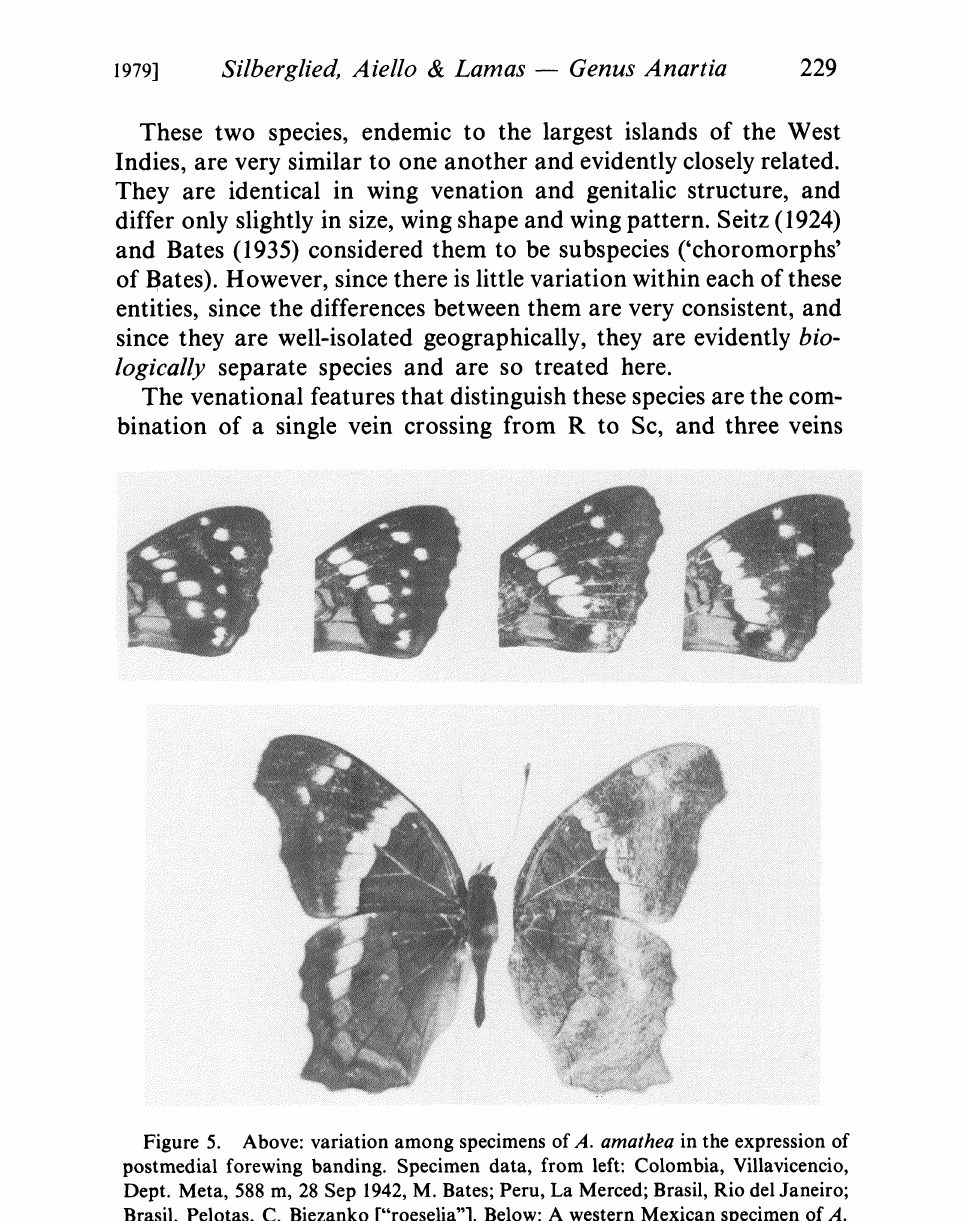
Figure 5. Above: variation among specimens of A. amathea in the expression of postmedial forewing banding. Specimen data, from left: Colombia, Villavicencio, Dept. Meta, 588 m, 28 Sep 1942, M. Bates; Peru, La Merced; Brasil, Rio del Janeiro; Brasil, Pelotas, C. Biezanko ["roeselia"]. Below: A western Mexican specimen of A. fatima illustrating extreme expression of dorsal hindwing red coloration, and ventral infuscation of the band. Specimen data: Mxico, Colima, Jacob Doll coll. ["colimen-